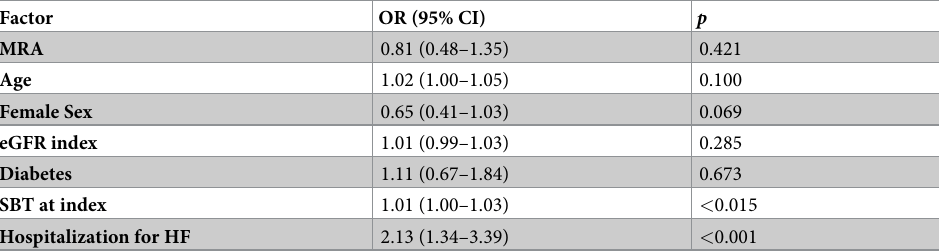
Table 2. Factors associated with worsening renal